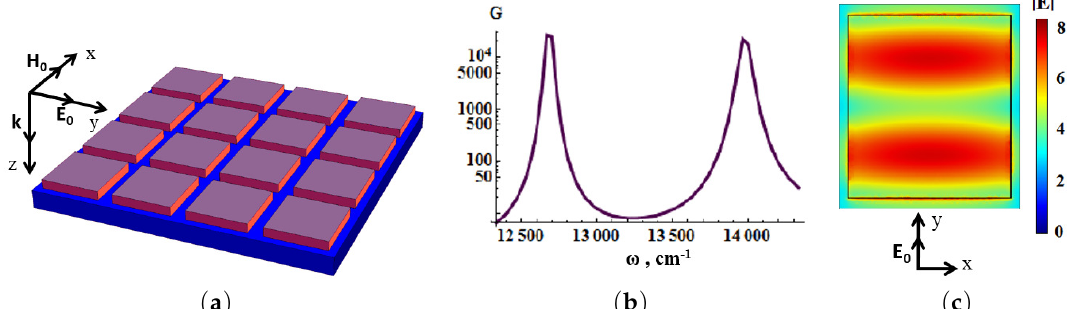
Figure 19. ( a ) 16 dielectric cuboids (purple) placed on the silver substrate (blue); ( b ) enhancement G as function of wavenumber for the dielectric cuboids placed on silver substrate, unit-cell dimensions of D x = 650nm, D y = 550nm, dielectric cuboid dimensions of dx = 585nm, dy = 495nm, and height h = 55nm. The incident laser beam is normal to metasurface, electric field in the beam is directed along the diagonal of the dielectric blocks. The enhancement G is obtained at the surface of dielectric cuboid; ( c ) local electric field mapping on the top of dielectric cuboids of the first resonance shown in ( b ) (from